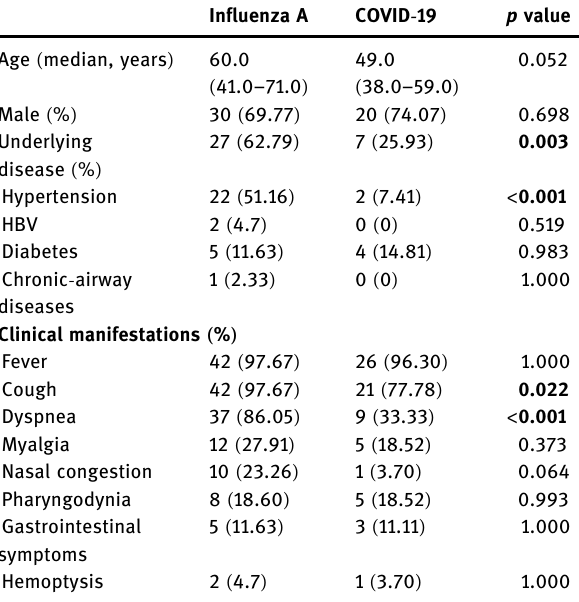
Table 1: Characteristics of